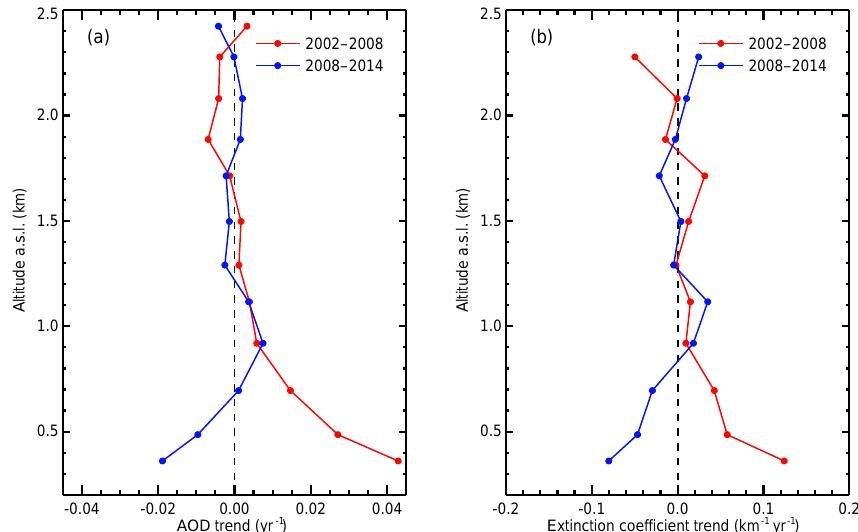
Figure 8. Vertical distributions of trends in summertime mean (a) AOD and (b) aerosol extinction coefficient. The vertical resolution is 200m. Red and blue lines represent tendencies during the period 2002–2008 and 2008–2014, respectively. The “a.s.l.” in the ordinate labels stands for “above sea